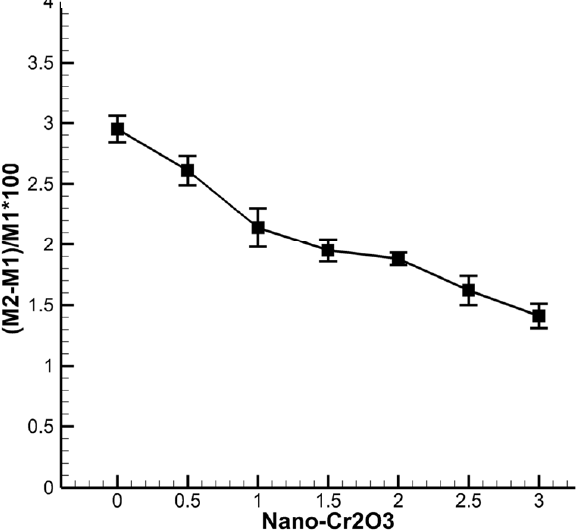
Fig. 6 Effect of Cr 2 O 3 nanoparticles addition on the improvement of hydration resistance of MgO-CaO samples